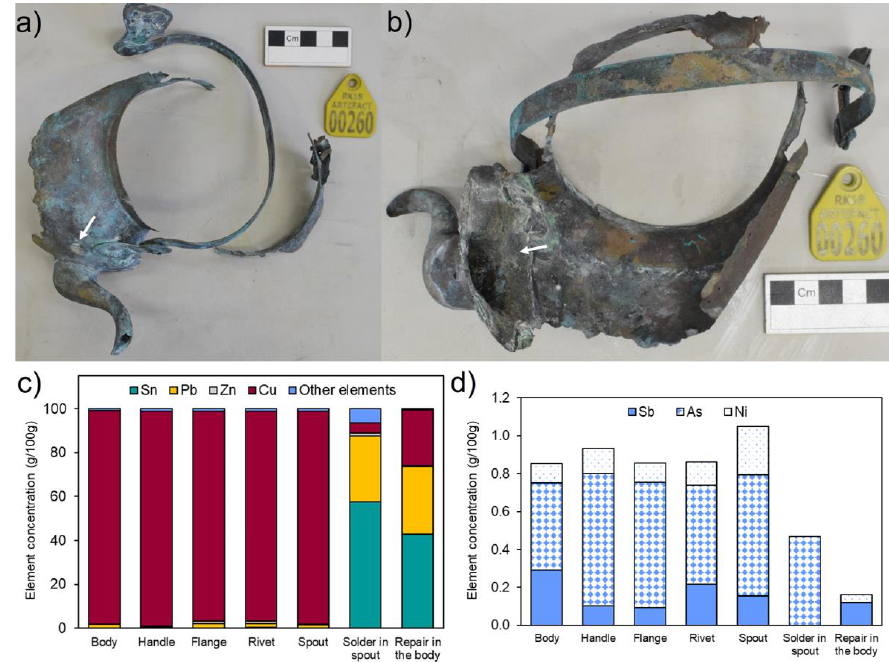
Figure 3. ( a , b ) Copper alloy teapot from the Rooswijk shipwreck (arrows indicate, on the left, a repair in the body and, on the right, a solder in the spout); ( c , d ) concentration of the elements in the alloys of the body, handle, flange, rivet, spout and in repairs of the